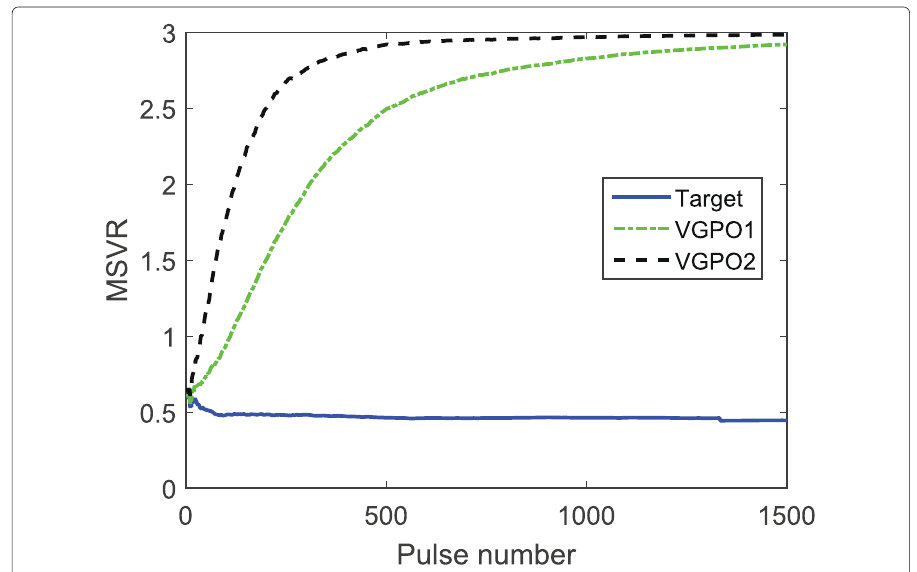
Fig. 7 The MSVR of the target echo and two kinds of jamming signals versus pulse